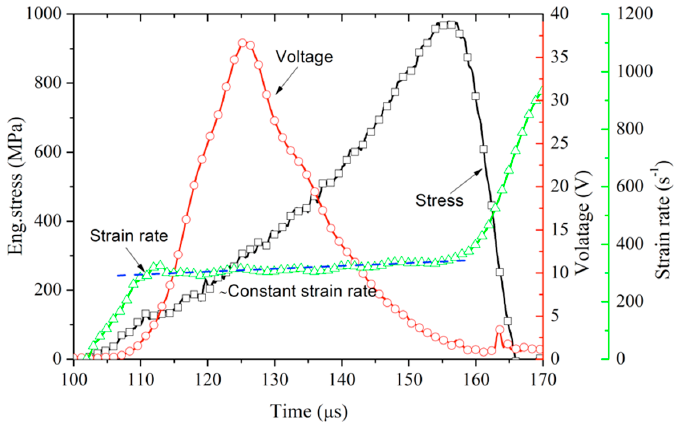
Figure 4. Profiles of strain rate, output voltage, and eng.stress for Pole PZT95/5 ceramic under high strain-rate loading.